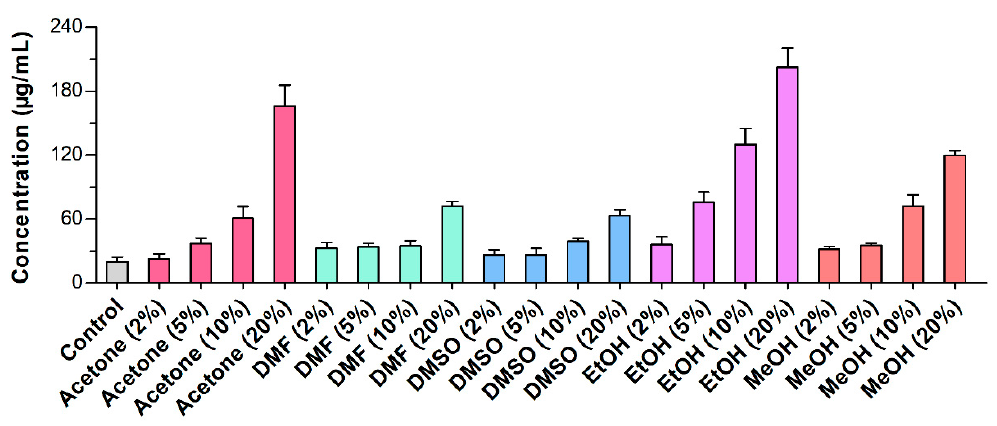
Figure 3. Concentrations of proteins released from E. coli BPGUT cells after the cells were exposed to 2% (v/v), 5% (v/v), 10% (v/v) and 20% (v/v) of acetone, DMF, DMSO, EtOH, and MeOH for 6 h, respectively.